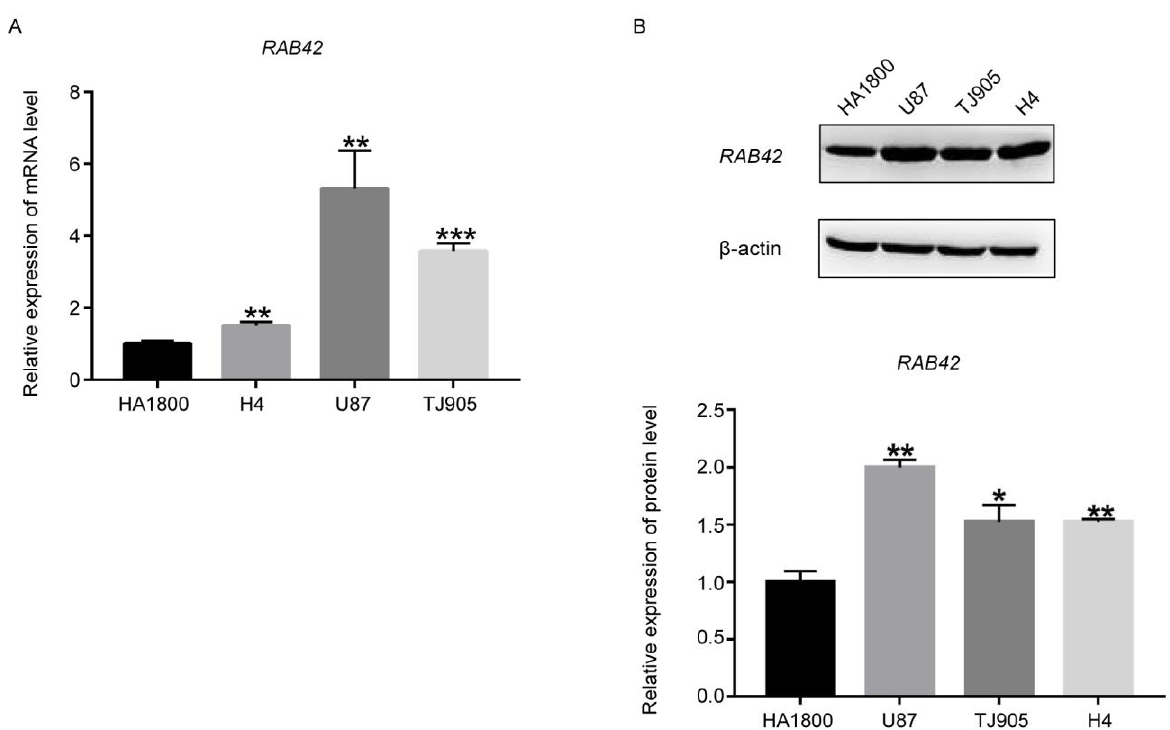
Figure 4. The RAB42 expression levels in local GBM cells and specmens. ( A – B ) RAB42 mRNA expression and protein expression were both upregulated in GBM cell lines, respectively (vs. HA1800; * p <0.05, ** p < 0.01, *** p < 0.001).